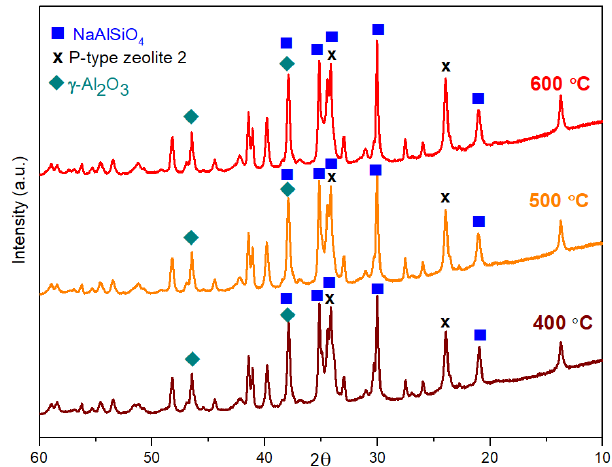
Figure 4. X-ray powder diffraction spectra of samples containing 33% red mud heat-treated at 100 ◦ C, 200 ◦ C, and 300 ◦ C.